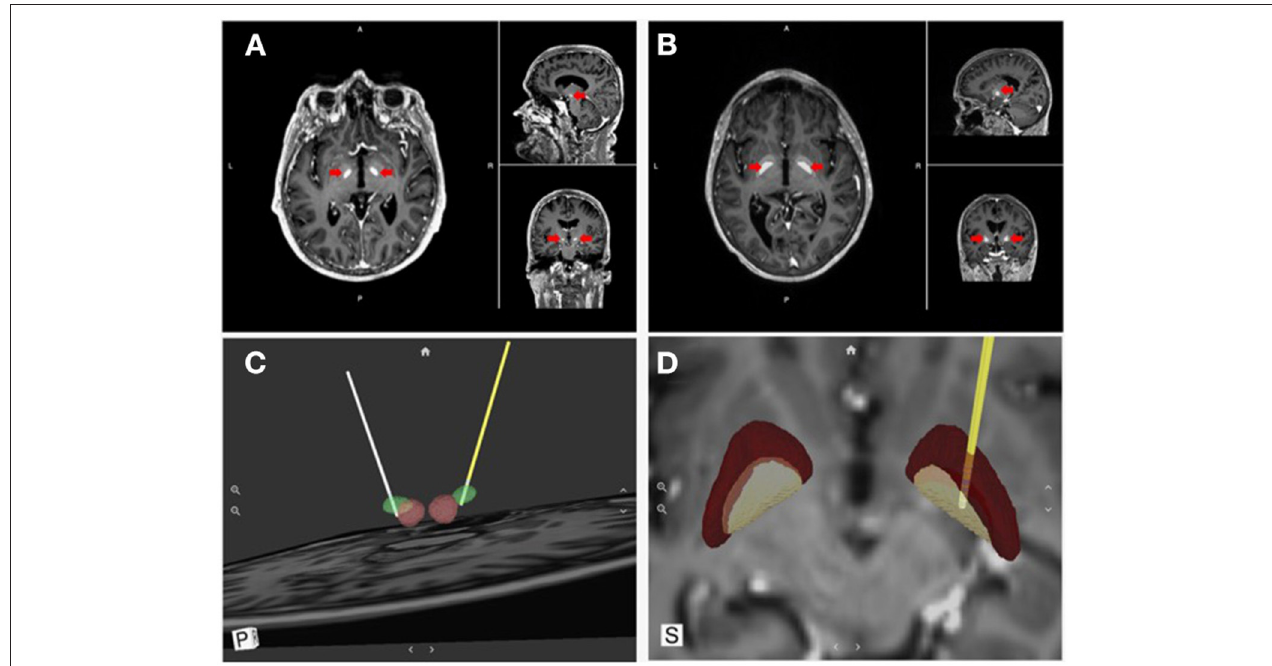
FIGURE 4 | Direct visualization of DBS targets and lead location. Surgical Information Sciences (SIS), provides a patient-specific model of DBS targets using the patient’s own enhanced clinical MR image. (A,B) shows alpha maps visualizing the STN and GPi, respectively (red arrows); (C,D) show 3D reconstructions of the intended targets registered with the DBS lead location in respect to the anatomical structures (STN & GPi, respectively).